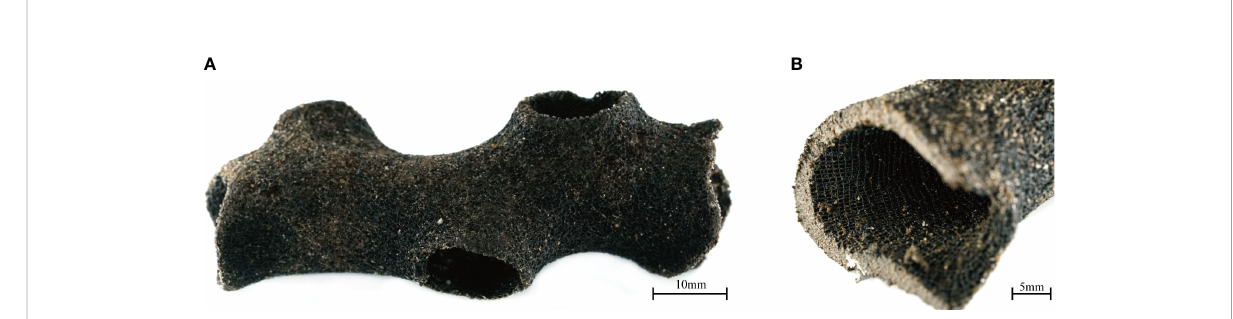
FIGURE 2 Photographs of the FMP sample: (A) Black colored ferromanganese oxide precipitated on the porifera and (B) section of FMP showing strati fi ed lattice-like structure